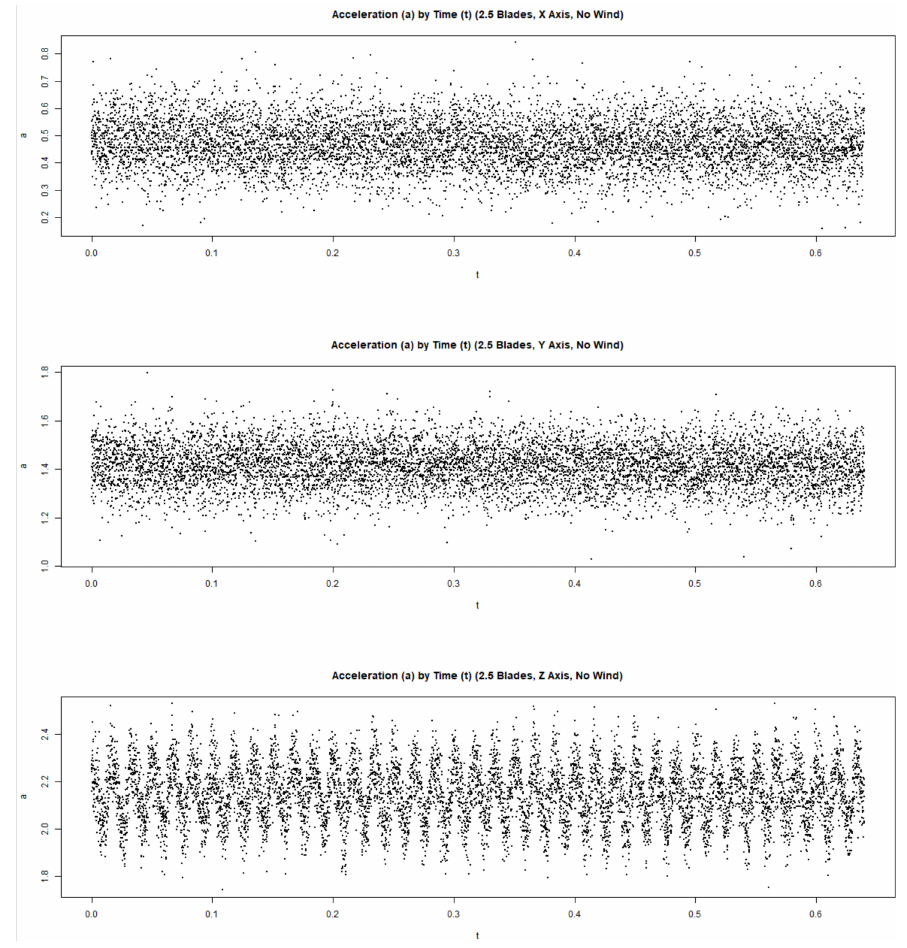
Figure 3. Acceleration signals recorded for the 2.5-blade (partially broken) turbine.